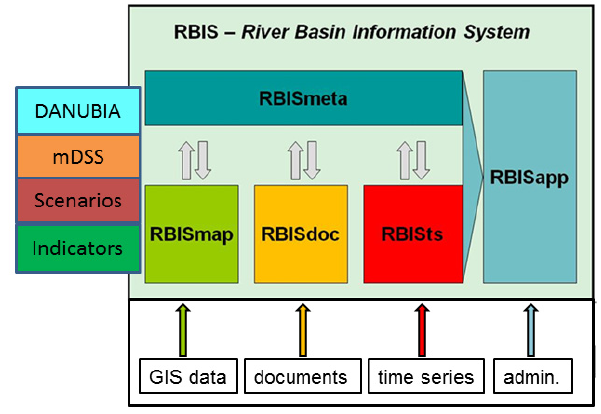
Figure 1. IWRMS data management architecture and data